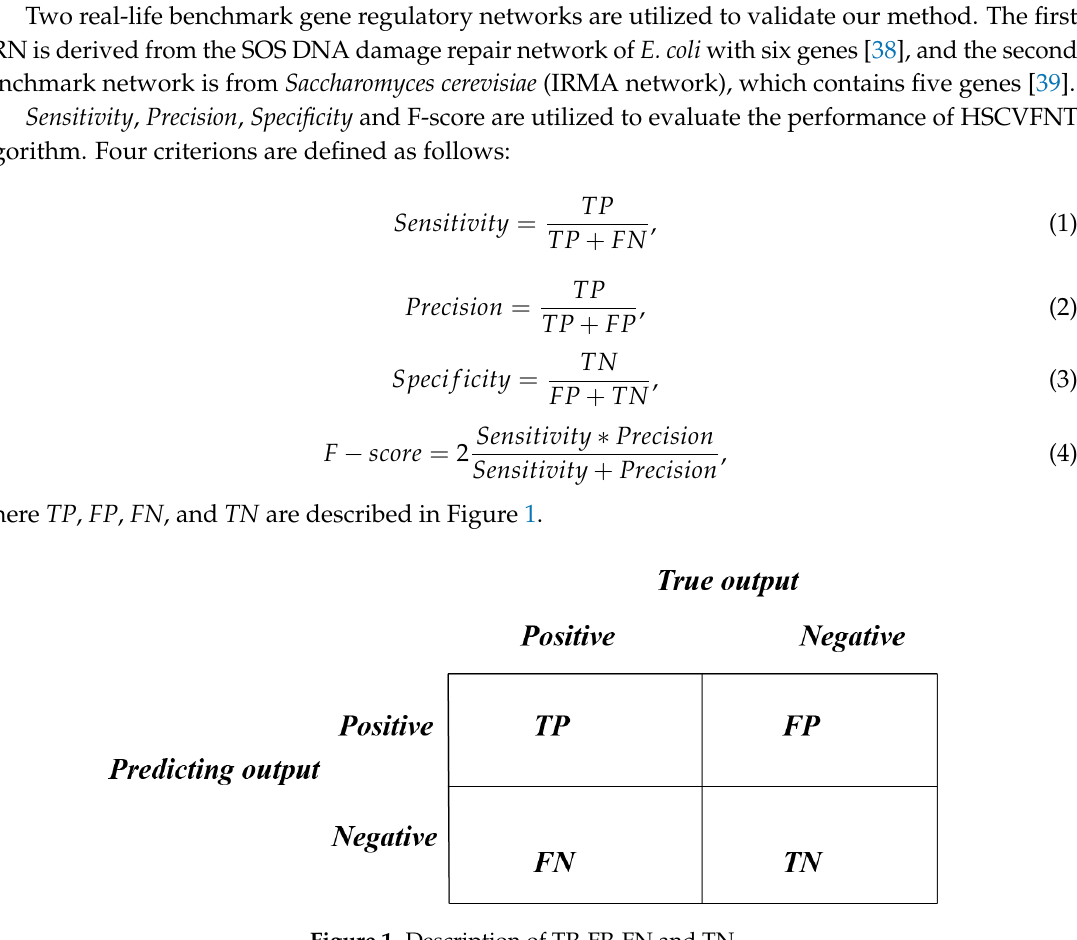
Figure 1. Description of TP, FP, FN and TN.